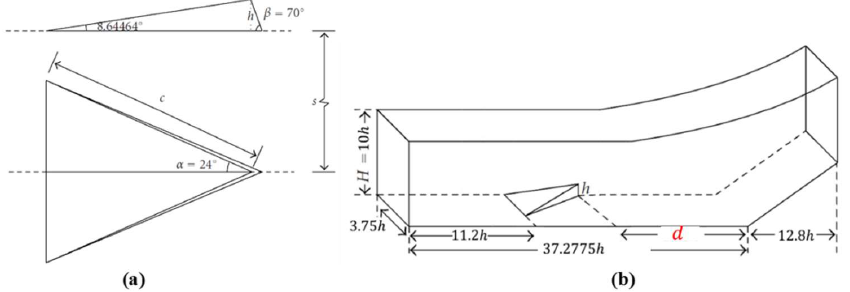
Figure 1. The dimensions of ( a ) MVG and ( b ) the half domain. The wall boundary applied non-slipping, zero-gradient for pressure and adiabatic boundary conditions. The upper boundary adopted non-reflecting boundary condition to prevent possible wave reflections. The conditions at the front and rear boundary surfaces in the spanwise direction are set as periodic, since the simulation is for the flow around MVG arrays and only one MVG is simulated. At the outflow boundary, a characteristic- based condition which can handle the outgoing flow without reflection is set. Twenty